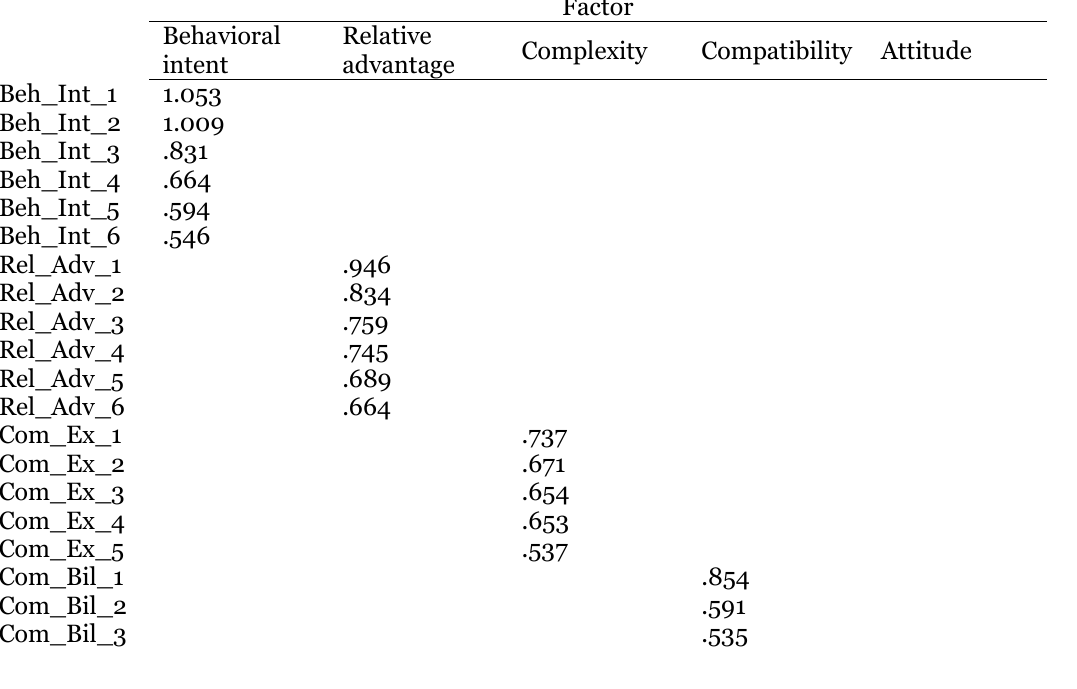
Exploratory Factor